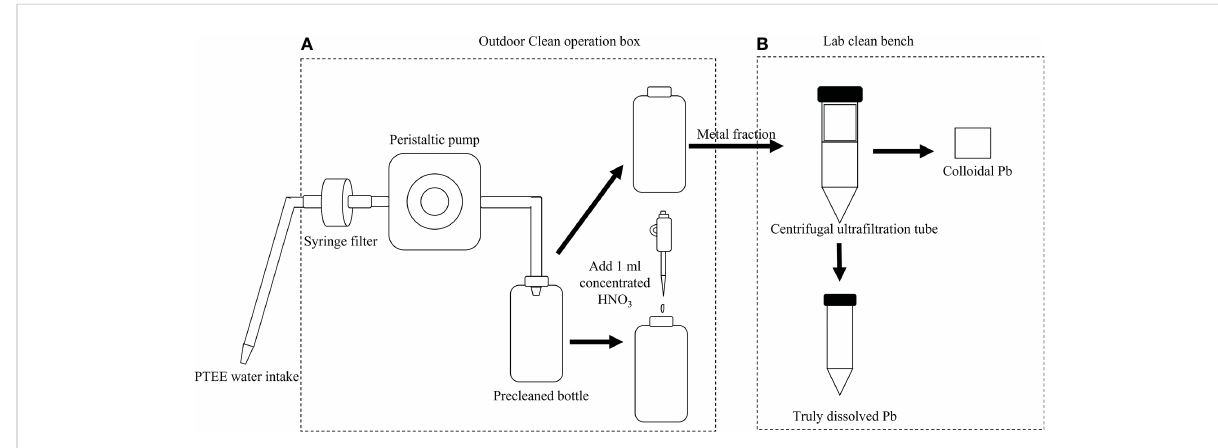
FIGURE 2 The diagram of clean sampling and metal fractionation. (A) The clean sampling process; and (B) the metal fractionation process.